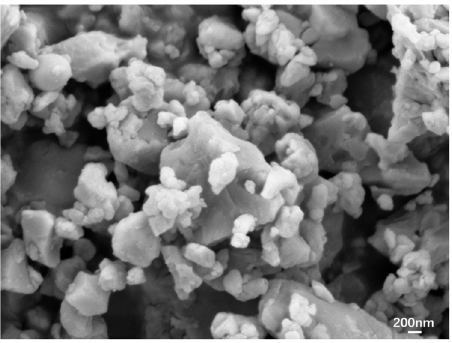
Figure 2: Scanning electron micrograph of nano - ZrSi 2 particles.